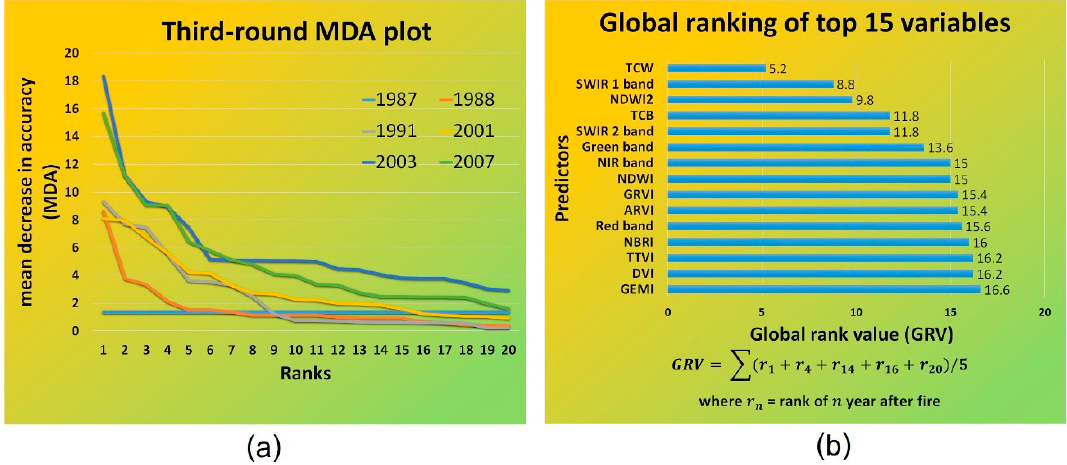
Figure 6. ( a ) Comparison plot of mean decrease in accuracy using the third-round RF-VIMP of each observation year; ( b ) the global ranking of the top 15 variables.